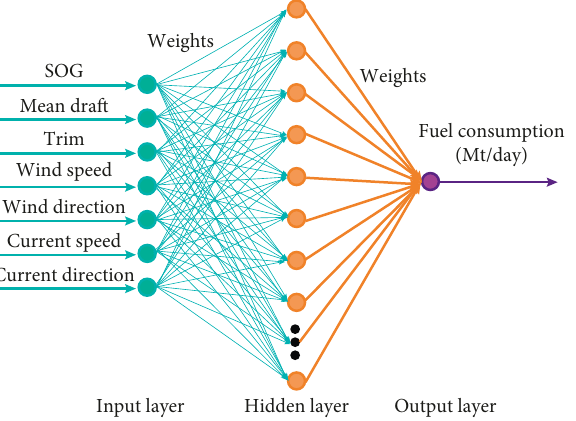
Figure 4: Structure of ANN model for fuel consumption.